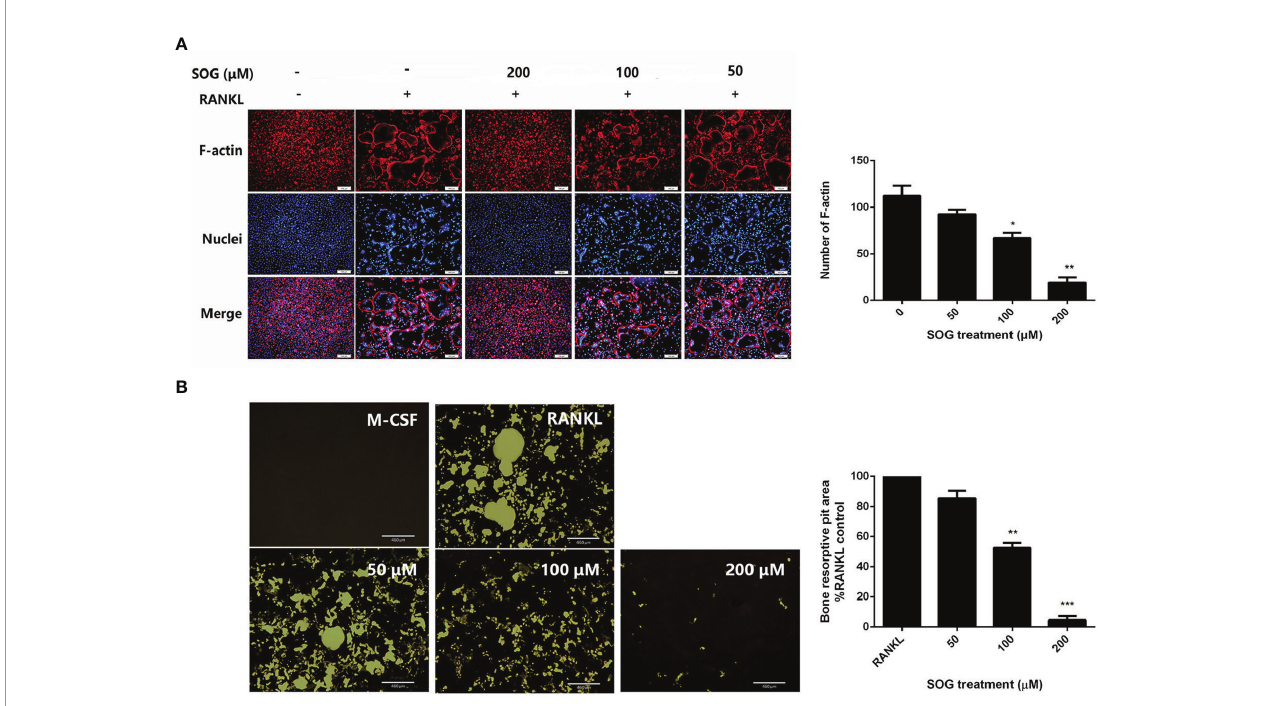
FIGURE 2 | SOG repressed the formation of F-actin ring resorption pits in RANKL-stimulated BMMs. (A) F-actin ring staining of BMMs cultured for 4 d with M-CSF, RANKL, and different concentrations of SOG. 100× magni fi cation. Scale bars, 100 m m. (B) Von Kossa staining of BMMs cultured for 4 d with M-CSF, RANKL, and different concentrations of SOG. Resorption pits were observed under a light microscope. 40× magni fi cation. Scale bars, 460 m m. All experiments were performed in duplicate at least three times. * p < 0.05, ** p < 0.01, *** p < 0.001 versus RANKL-positive